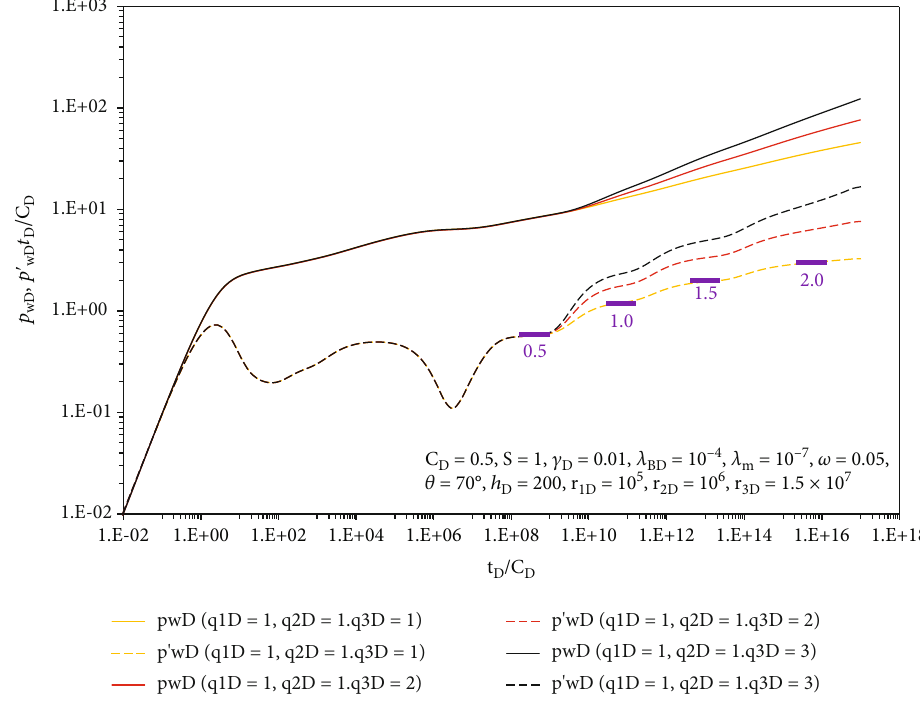
Figure 8: In fl uence of production of adjacent wells on pressure dynamic curve.